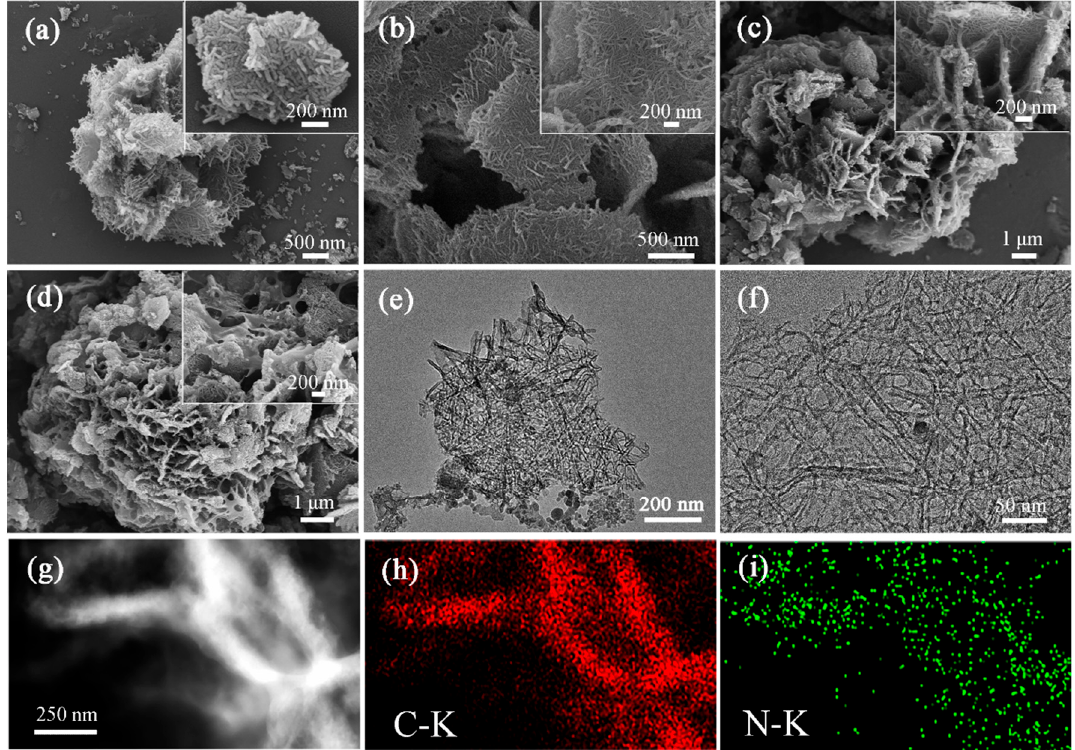
Figure 3. SEM images for PEI@SiO 2 ( a ), SiO 2 @C, ( b ) an N-doped CNFs sample of N CNFs-1, ( c ) and N CNFs-2 ( d ). ( e , f ) Shows the TEM images for sample of N CNFs-1 with different magnifications. ( g – i ) Shows the TEM dark field image and the corresponding energy dispersive spectrometer (EDS) element mapping results for N CNFs-1.